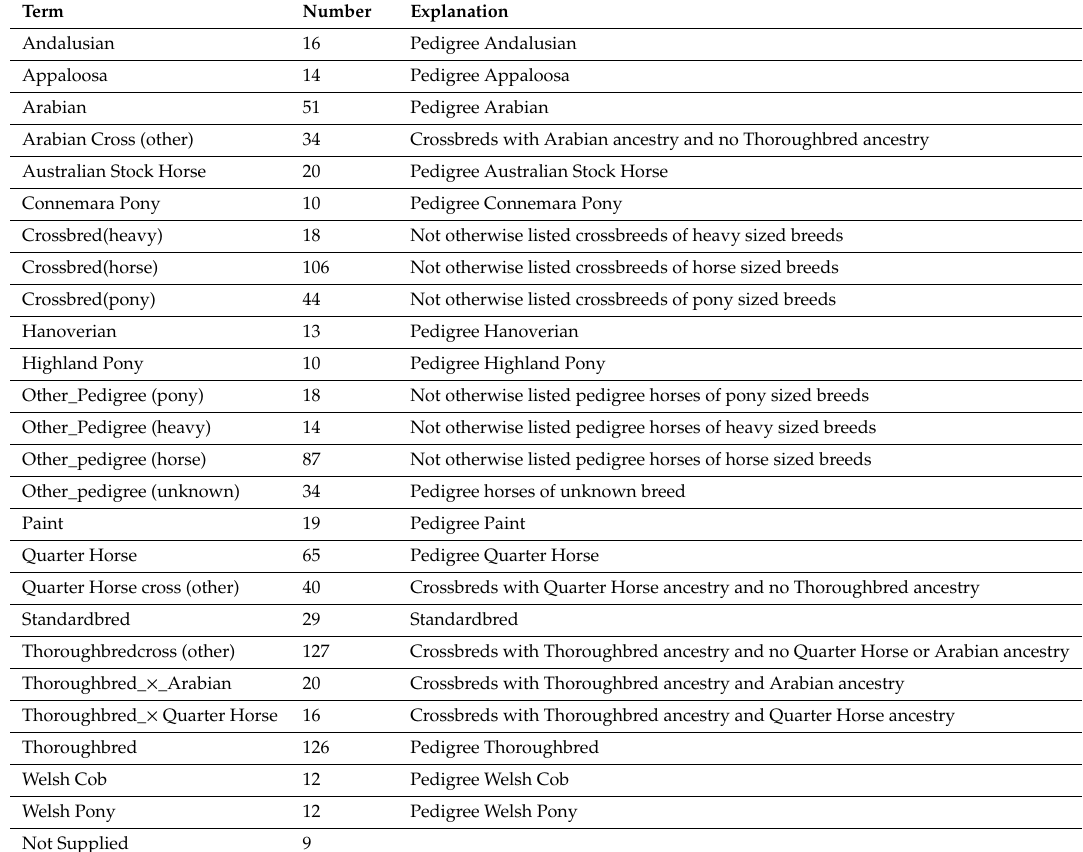
Table 2. The distribution of breeds of horse reported on in full by respondents (n = 1233) included as a variable in the multivariable